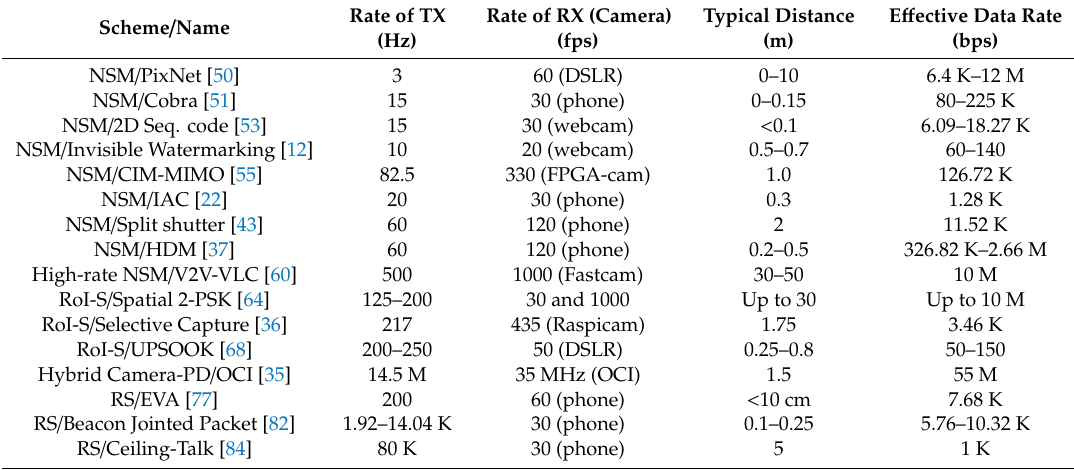
Table 3. Performance comparison of representative OCC